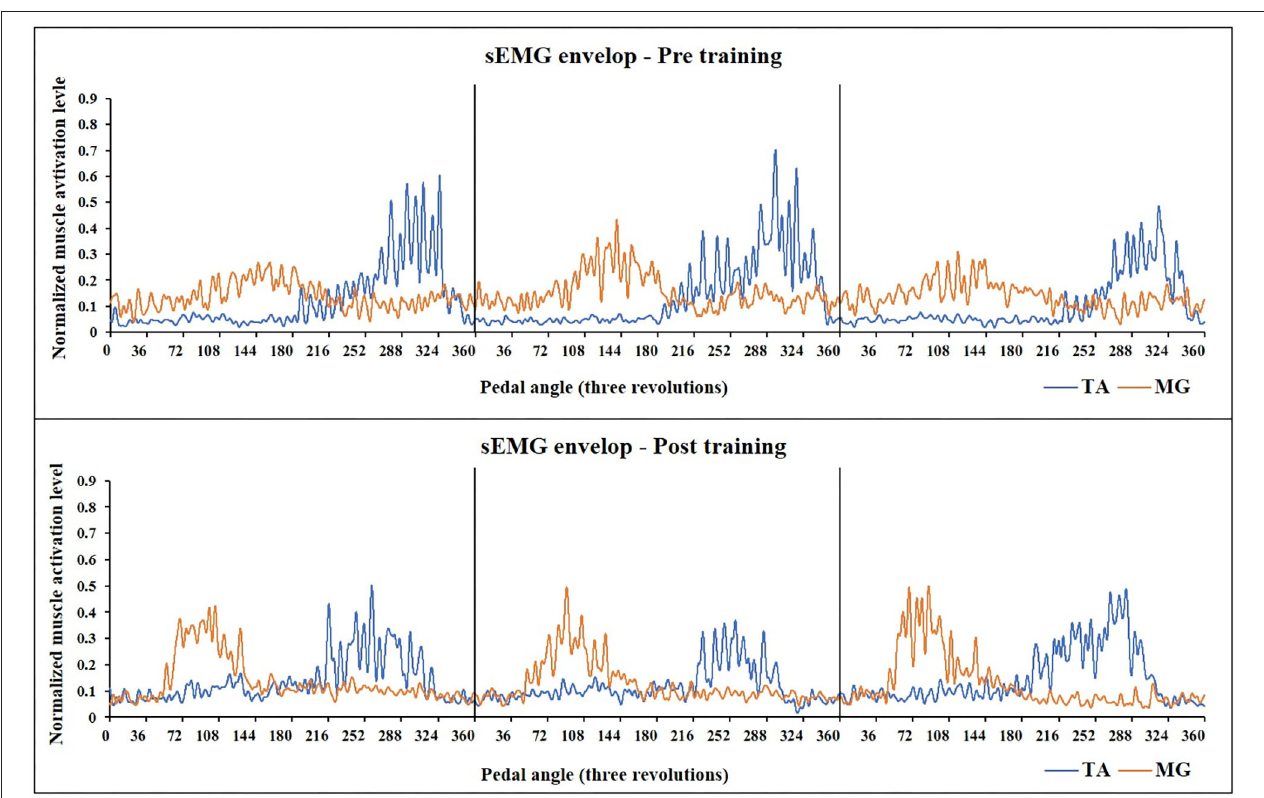
FIGURE 6 | Muscle activation alteration of TA and MG before and after training in one subject (Subject No 12). The sEMG-enveloped signal during the middle three revolutions of cycling is demonstrated. X-axis represents the cycling angles of the pedals. The zero degree of the pedal was set so that the two pedals were in the same line which was vertical to the ground. Yellow curve: sEMG envelope of MG, Blue curve: sEMG envelope of TA. After training, the activation of both two muscle pairs decreased, and MG muscle presented a more independent and rhythmic activation pattern (CI value of TA and MR muscle pair: pretraining: 0.168, posttraining: 0.139). TA, tibialis anterior; sEMG, surface electromyography; MG, medial head of